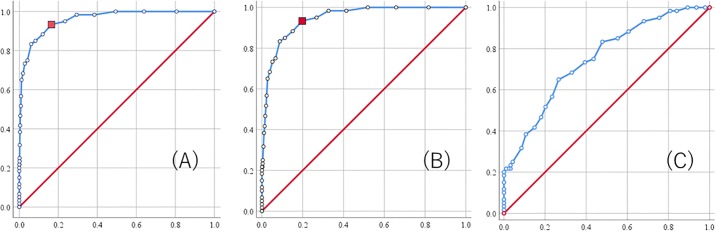
Receiver Operating Characteristic curve for the ASSQ scores.(A) ROC curve for ASD and community children. (B) ROC curve for ASD and community + non-ASD children. (C) ROC curve for ASD and non-ASD children.